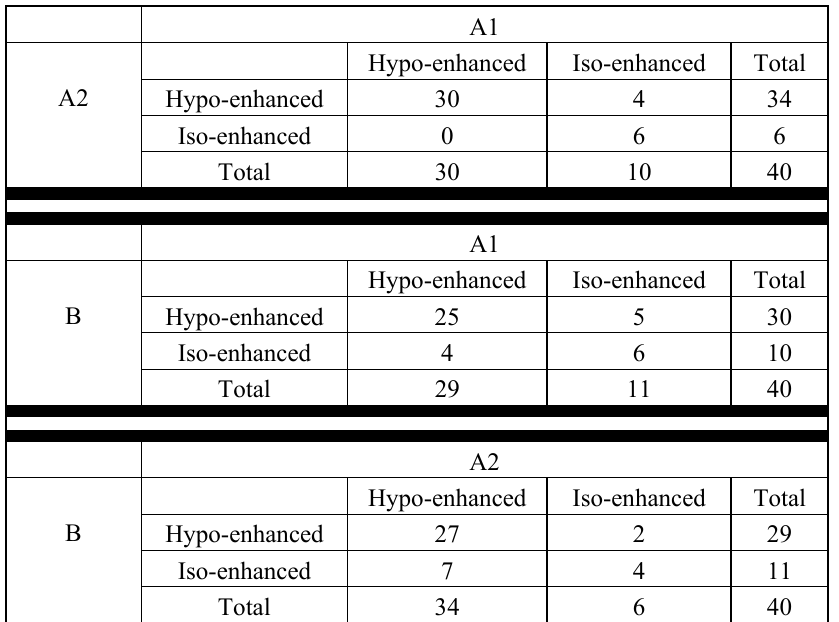
Table 2. Distribution of the observations concerning isoenhancement and hypoenhancement .